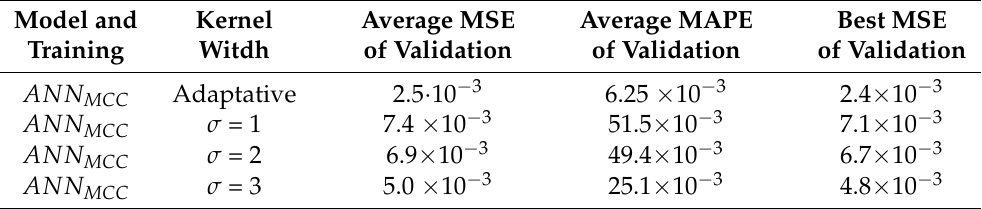
Table 3. Performance comparison of ANN models. State of Charge—training result with the presence of noise or